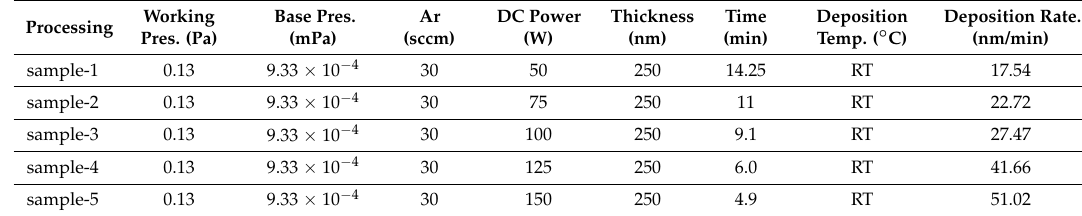
Table 1. Detail of parameters of the IZTO films with various sputtering powers.